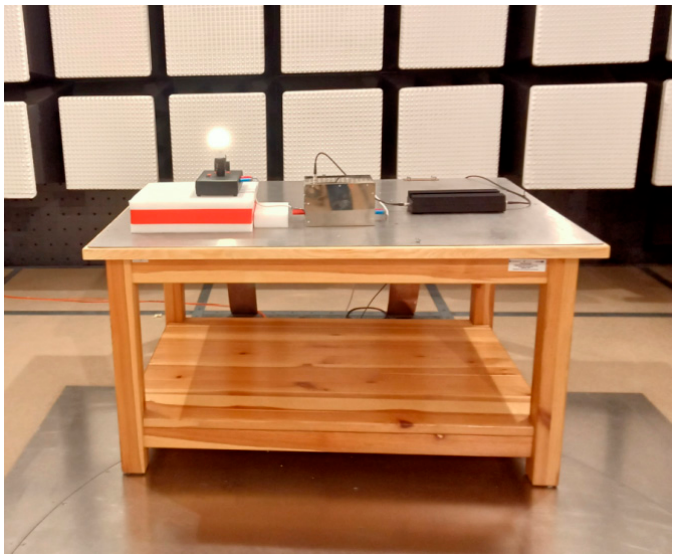
Figure 3. Measuring stand for determination of conducted disturbance emissions generated by the LED lamp under test in the range of 30 to 300 MHz using the CDNE method.